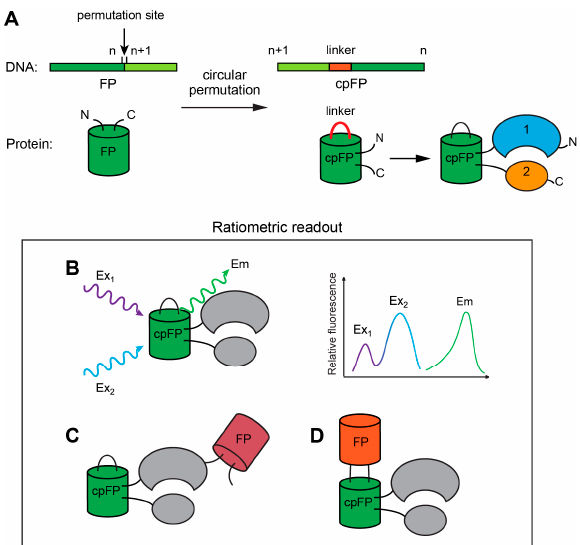
Figure 1. Basic principles of cpFP-based biosensors . ( A ) The scheme of FP circular permutation at the DNA and protein levels. The resulting cpFP can be integrated between the interacting units (1 and 2) of the sensory domain. Units 1 and 2 can be different proteins, subunits or domains of the same protein. ( B – D ) Variants of cpFP-based biosensors with ratiometric readout. ( B ) The ratiometric biosensor can be developed on the basis of a single cpFP, since some are characterized by the presence of two peaks in the fluorescence excitation spectrum. ( С ) A second FP with different spectral properties can be attached to the N- or C-termini of a biosensor. ( D ) (Green-Orange)-Matryoshka cassette for designing ratiometric biosensors.